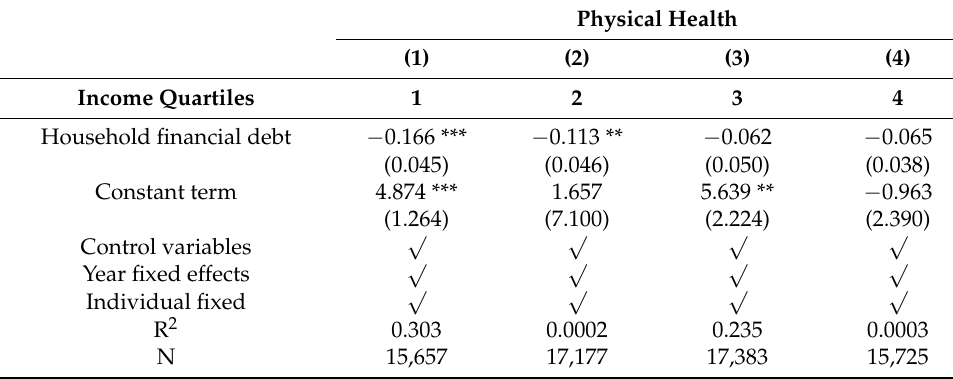
Table 9. Regression results of income